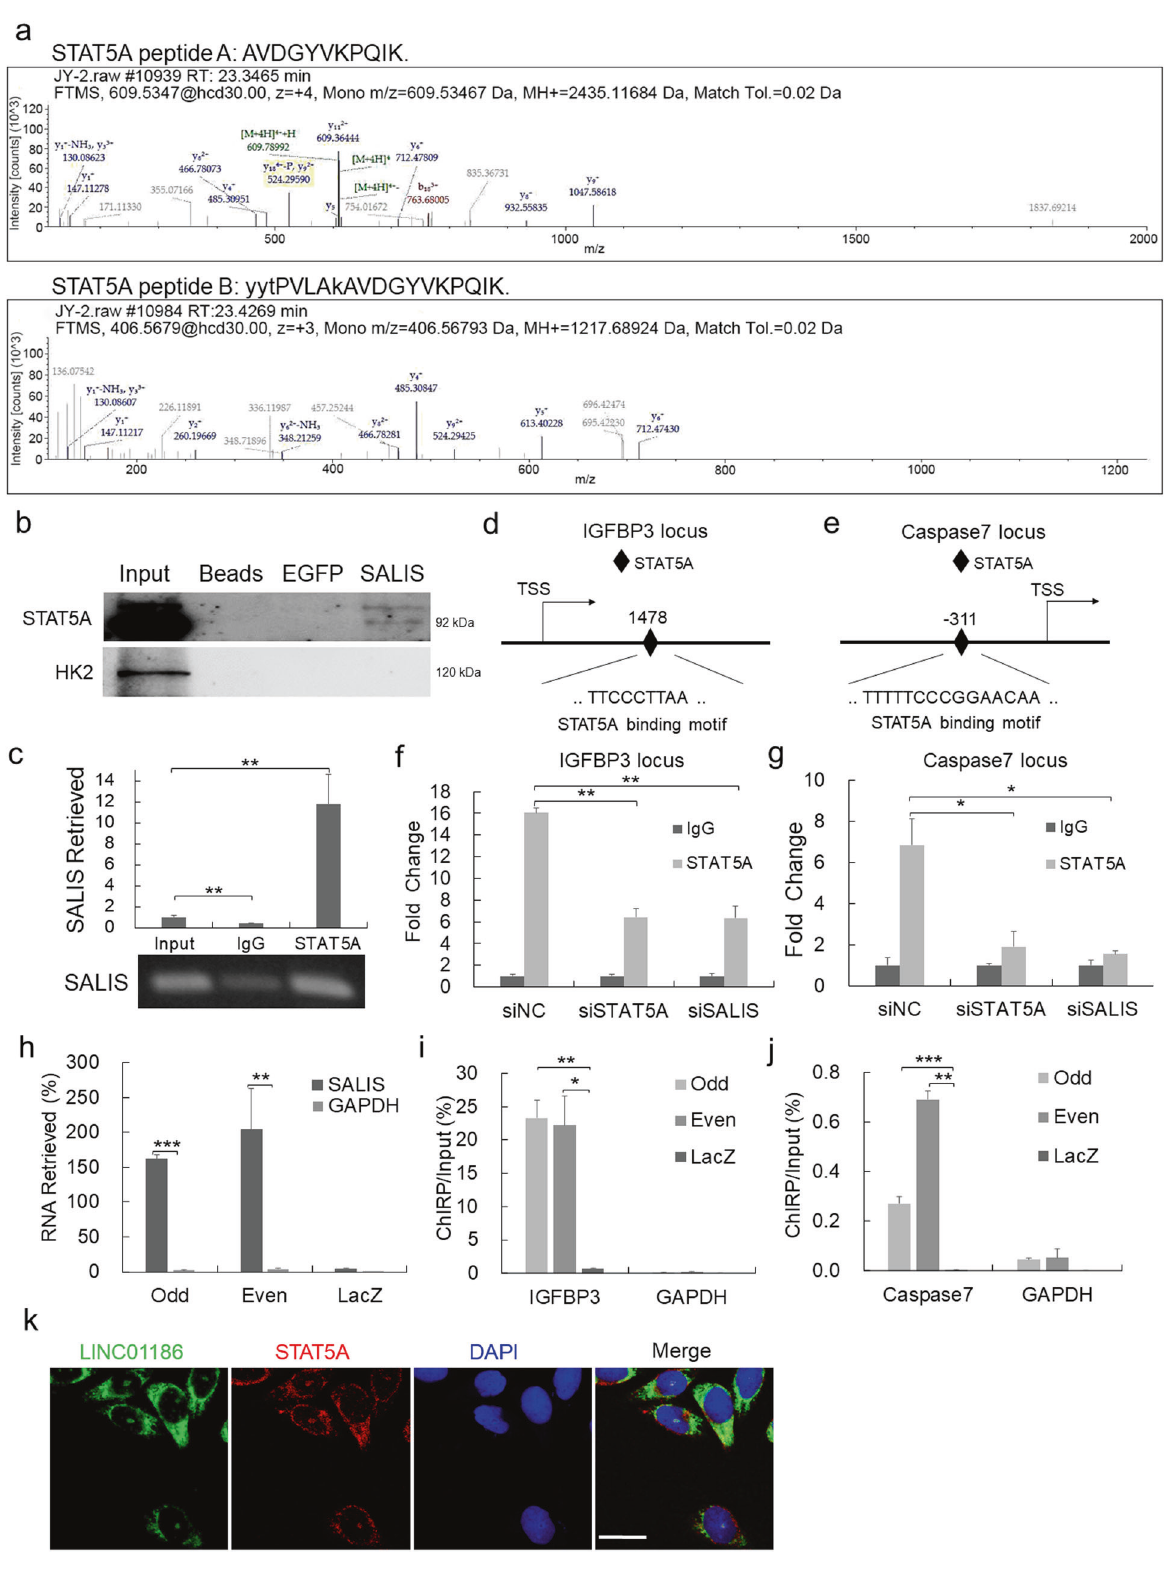
Together, the above results suggest that STAT5A plays key role for SALIS to establish the transcriptional repression of IGFBP3 and Caspase-7 and inhibits apoptosis in HCC